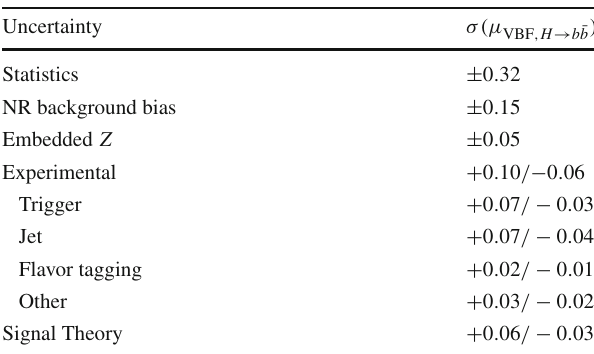
Table 5 Breakdown of the observed uncertainties on the inclusive pro- duction signal strength measurement ( μ VBF , H → b ¯ b